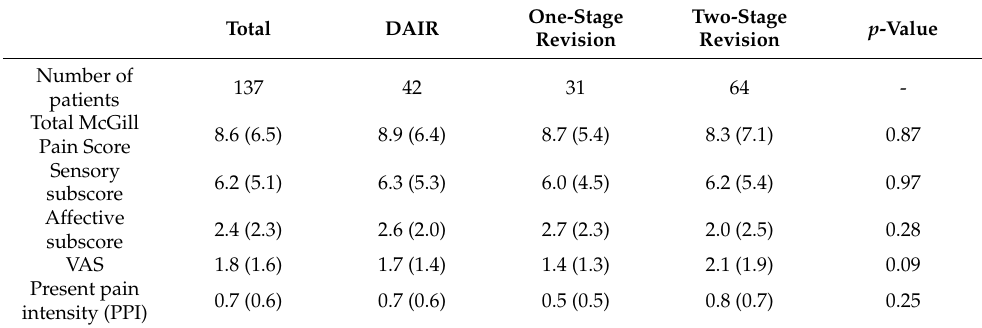
Table 3. Total and subscale scores of McGill Pain Score among the three groups.